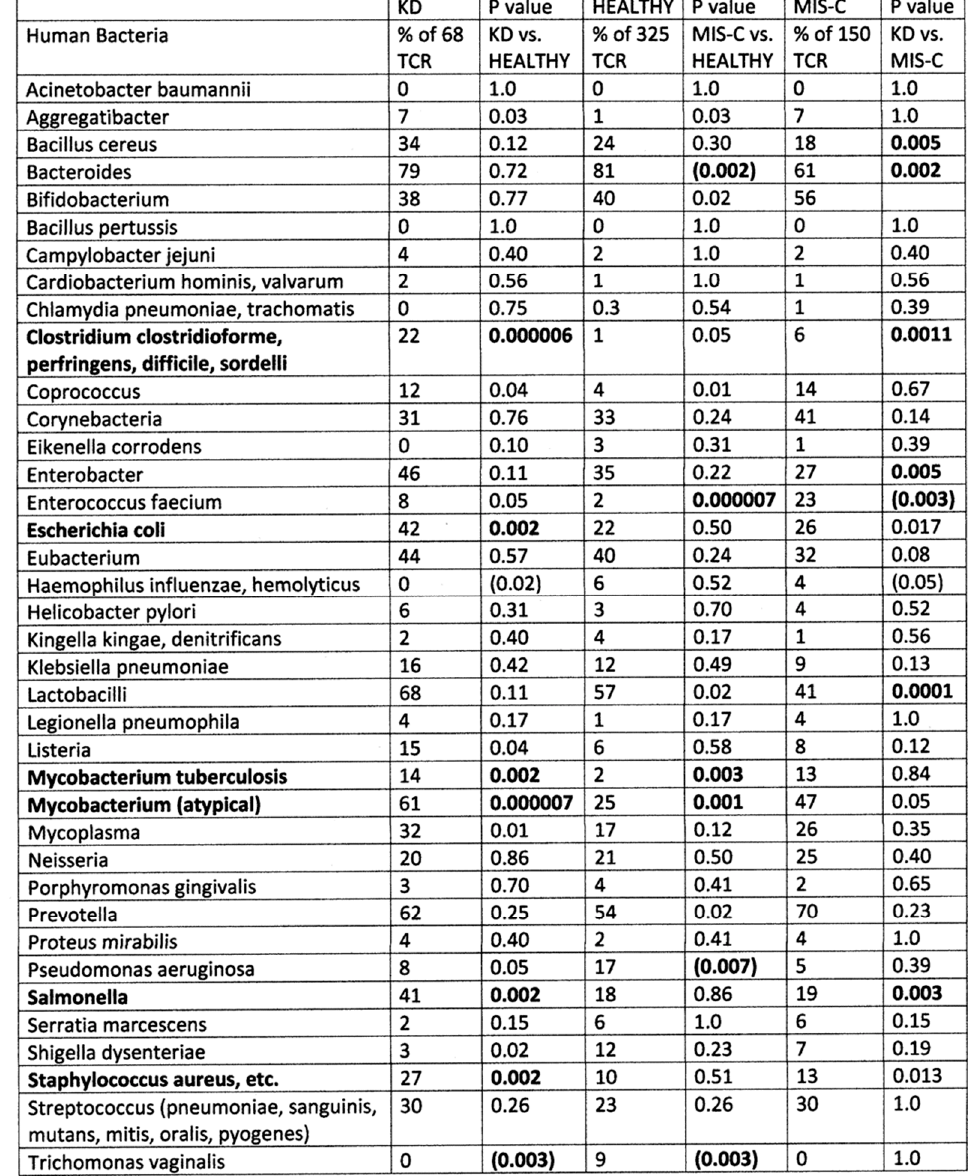
Figure 6. Summary of frequency (by percentage of TCRs tested) of TCR sequence similarities for Kawasaki disease (KD) patients, healthy individuals, and multisystem inflammatory syndrome in children (MIS-C) patients to bacterial proteins that may be targets of autoimmunity in these diseases. The statistical significance of differences between each pairing was determined by chi-squared analysis providing a p value. However, because each TCR was analyzed against every virus, a Bonferroni correction was required to interpret the resulting p values such that to reach a significance of p < 0.05 after the correction, the chi-squared value must be 0.002 or less. Values less than 0.002 or approaching it are bolded in the figure for ease of recognition. p values in parentheses indicate that there is a significant decrease in prevalence of matches compared with the healthy